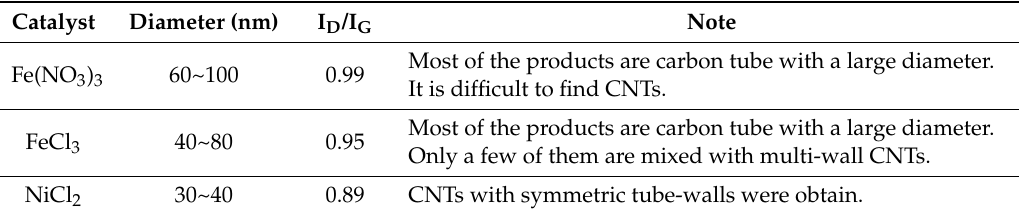
Table 1. Comparison of carbon tubes prepared with different catalysts. CNTs: carbon nanotubes. Catalyst Diameter